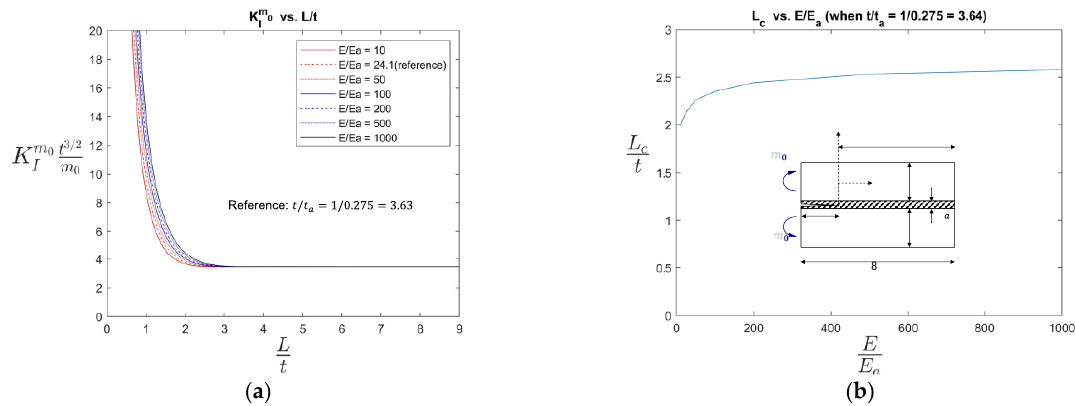
Figure 16. The normalized critical bond length 𝐿 𝑐 /𝑡 as a function of 𝐸/𝐸 𝑎 — Case 1 subjected to the pure moment 𝑚 0 with 𝑡/𝑡 𝑎 = 3.63. ( a ) Normalized 𝐾 𝐼 as a function of 𝐿/𝑡 . ( b ) Normalized critical bond length ( 𝐿 𝑐 /𝑡 ) as a function of 𝐸/𝐸 𝑎 .